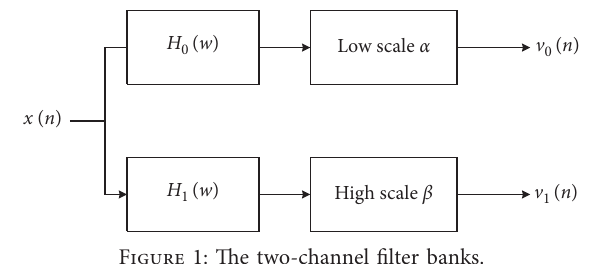
Figure 1: The two-channel filter